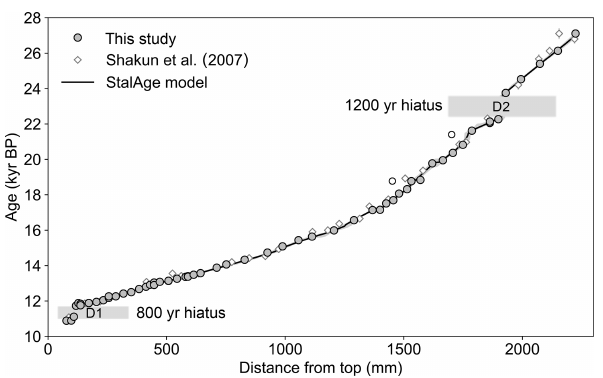
Figure 3. U-series ages vs. depth. Error bars reflect 2 σ statistical uncertainty but are mostly covered by the data points. The solid line represents the established age model obtained by sectional imple- mentation of the StalAge algorithm (Scholz and Hoffmann, 2011). Two data points implying age inversions (empty circles) in an oth- erwise steady record were omitted. Diamonds represent data from a previous study (Shakun et al., 2007). Growth discontinuities D1 and D2 are highlighted by gray